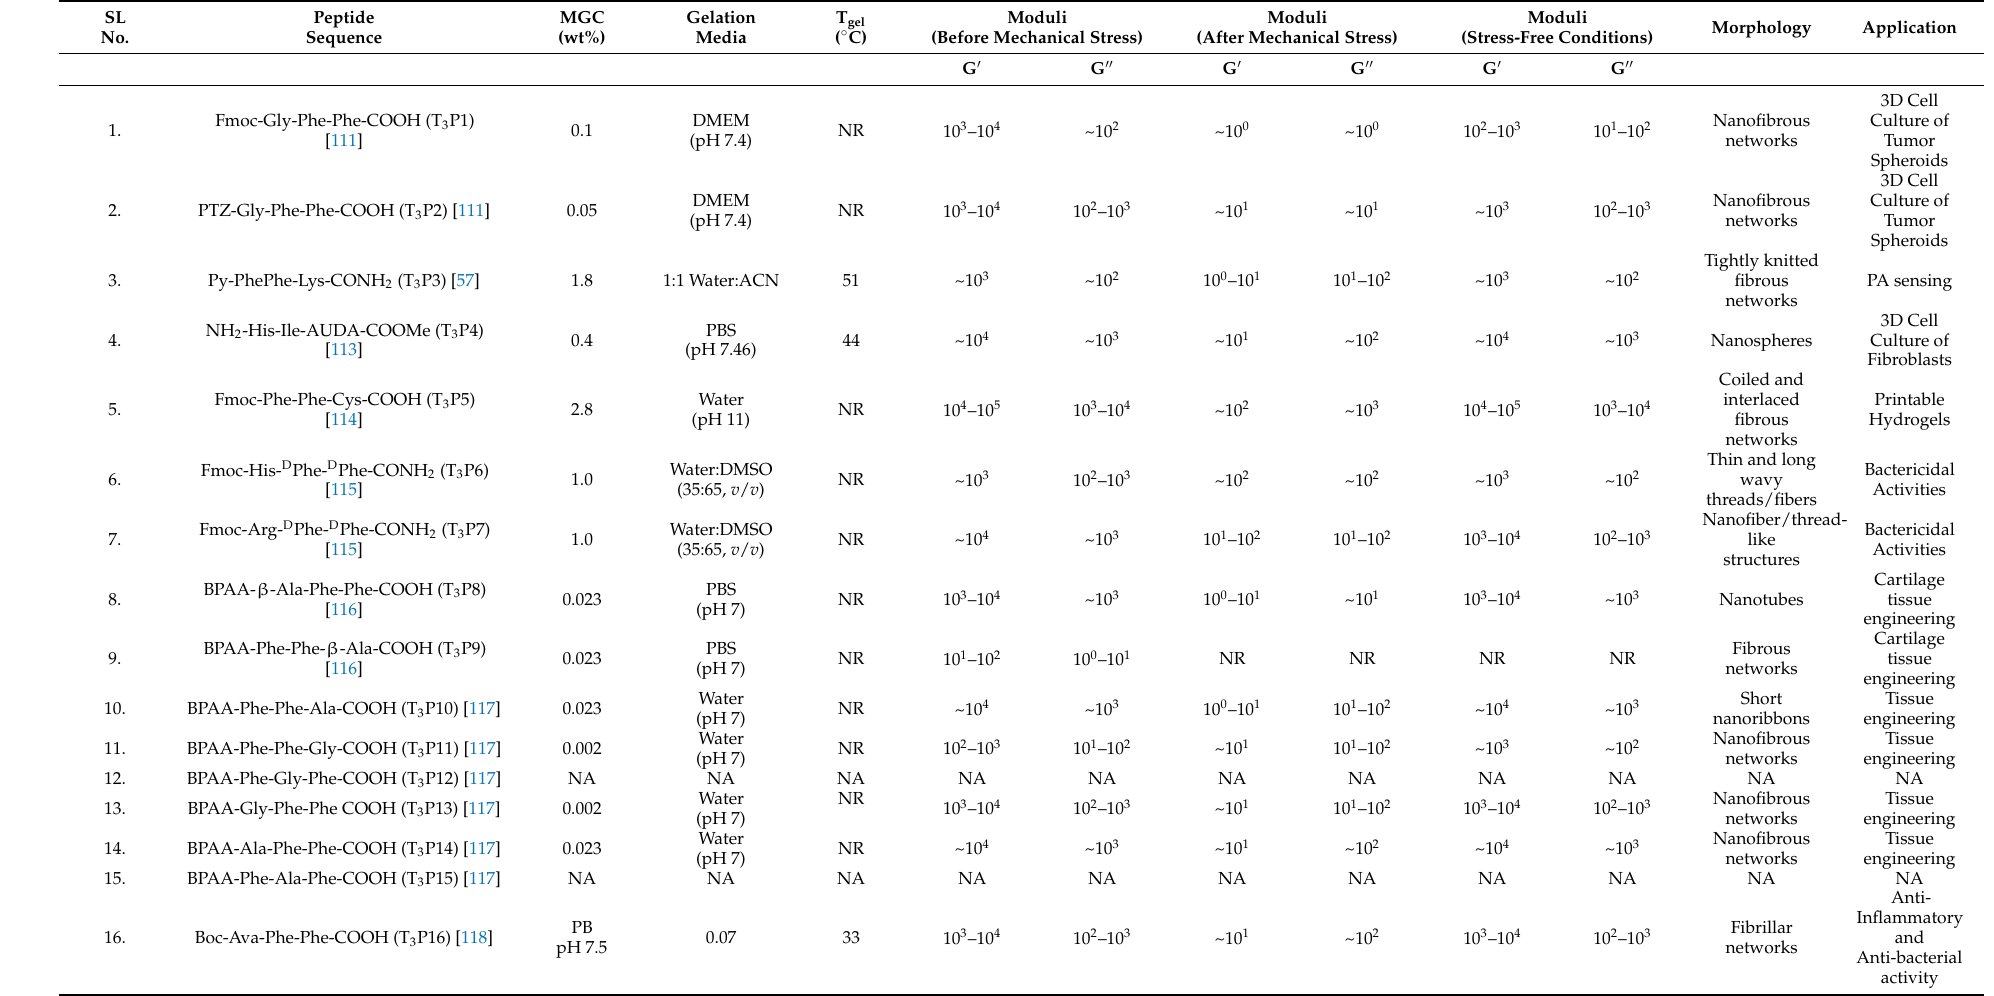
Table 4. List of tripeptide (T 3 P)-based thixotropic hydrogelators and respective gelation